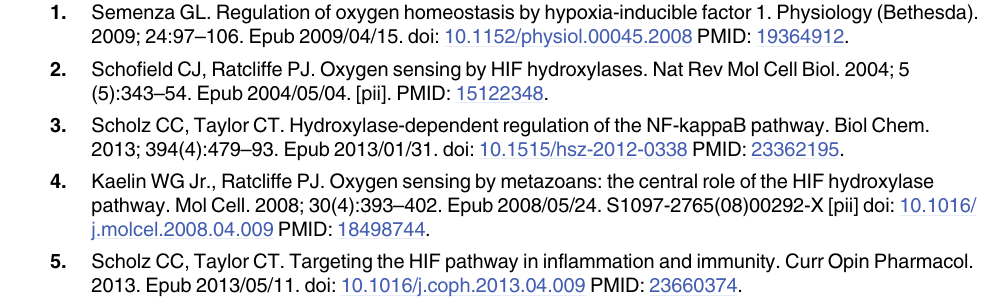
S7 Fig. Point mutation of asparagine 22 to alanine regulates the association of OTUB1 with proteins of different pathways. (A) Gene Ontology analysis for biological processes of proteins significantly enriched and increased by at least 2-fold in FLAG-OTUB1 WT over con- trol. (B) Gene Ontology analysis for biological processes of the proteins significantly enriched and increased by at least 2-fold in FLAG-OTUB1 N22A over control. The analyses were per- formed using Panther database (www.pantherdb.org). S8 Fig. Establishment of stably transfected cells lines. HEK293 cells were stably transfected with either empty vector (control), FLAG-OTUB1 WT or FLAG-OTUB1 N22A alone or with the combination of control and a non-targeting shRNA (shControl), control and a shRNA tar- geting the 3 0 UTR of OTUB1 (shOTUB1), FLAG-OTUB1 WT and shOTUB1, or FLAG-O- TUB1 N22A and shOTUB1. OTUB1 overexpression and knockdown were determined by western blot. S1 Table. DAVID Functional annotation of metabolic proteins significantly enriched in the OTUB1 N22A over WT interactome. Proteins significantly enriched in OTUB1 N22A co- precipitants over OTUB1 WT co-precipitants were analyzed with DAVID Bioinformatics Resources (http://david.abcc.ncifcrf.gov/) for functional annotation clustering. Listed are the obtained clusters and proteins for metabolic